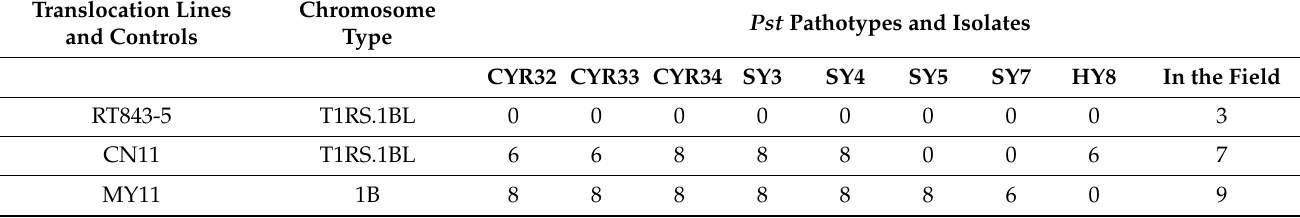
Table 1. Responses to different stripe rust races/isolates of RT843-5.